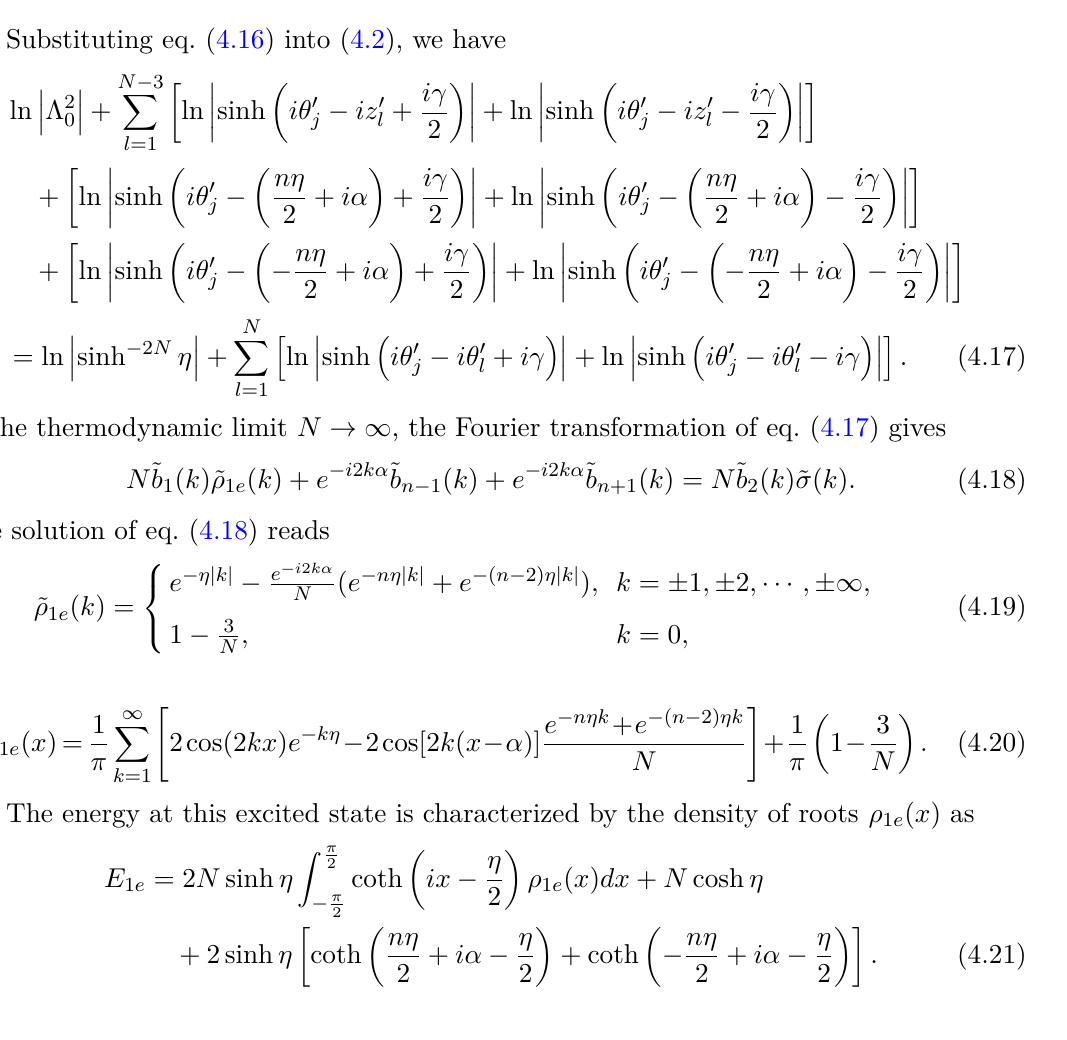
Figure 3 . (a) The distribution of zero roots { z j } of Λ( u ) at the excited state for N = 10 and η = 0 . 75 . (b) The difference δE 1 e between the excited state energy calculated from eq. (4.21) and that obtained by numerical exact diagonalization of the Hamiltonian (2.1) with the system-size N . The data can be fitted as δE 1 e = 130 . 4 e − 0 . 826 N